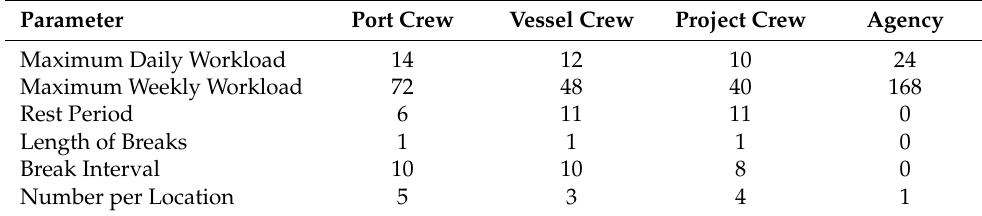
Table 4. Parameters for the crew